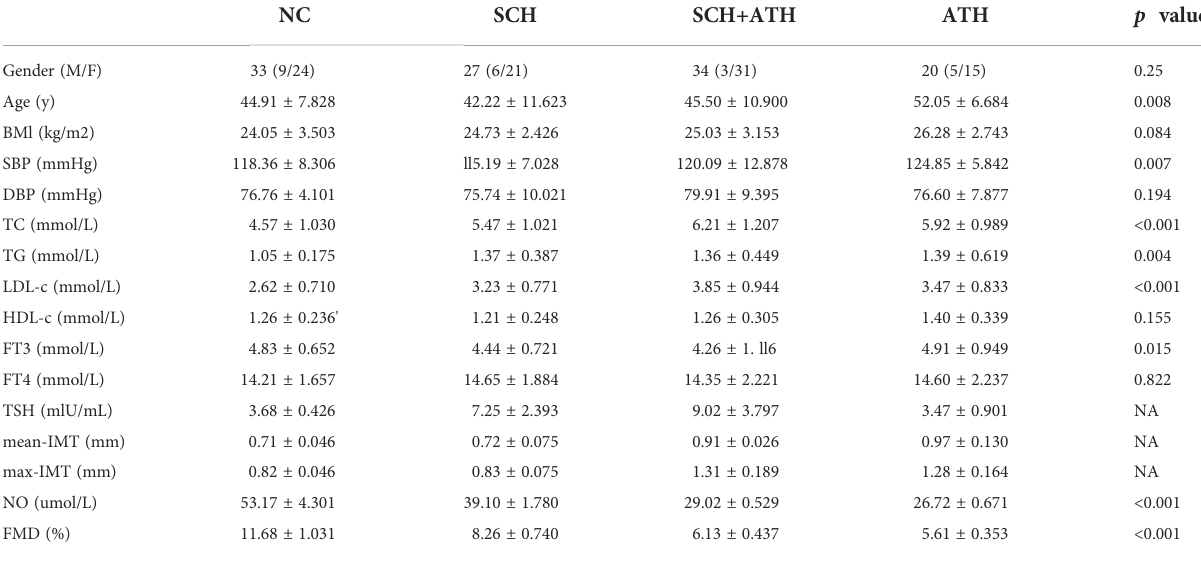
TABLE 1 Charactices of Subjects inthis